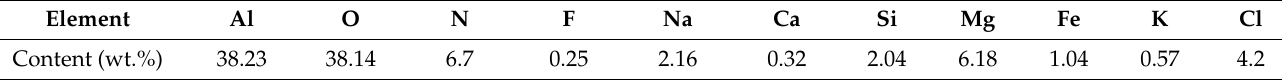
Figure 2. XRD pattern of the SAD sample.